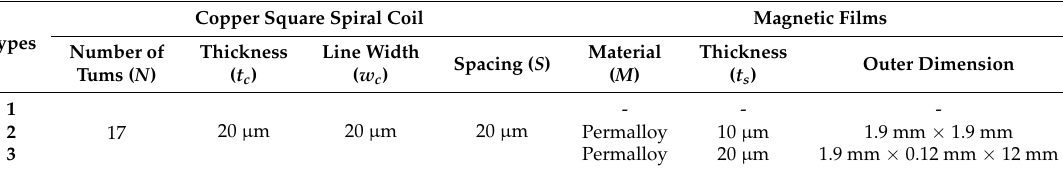
Table 1. Specifications of three planar